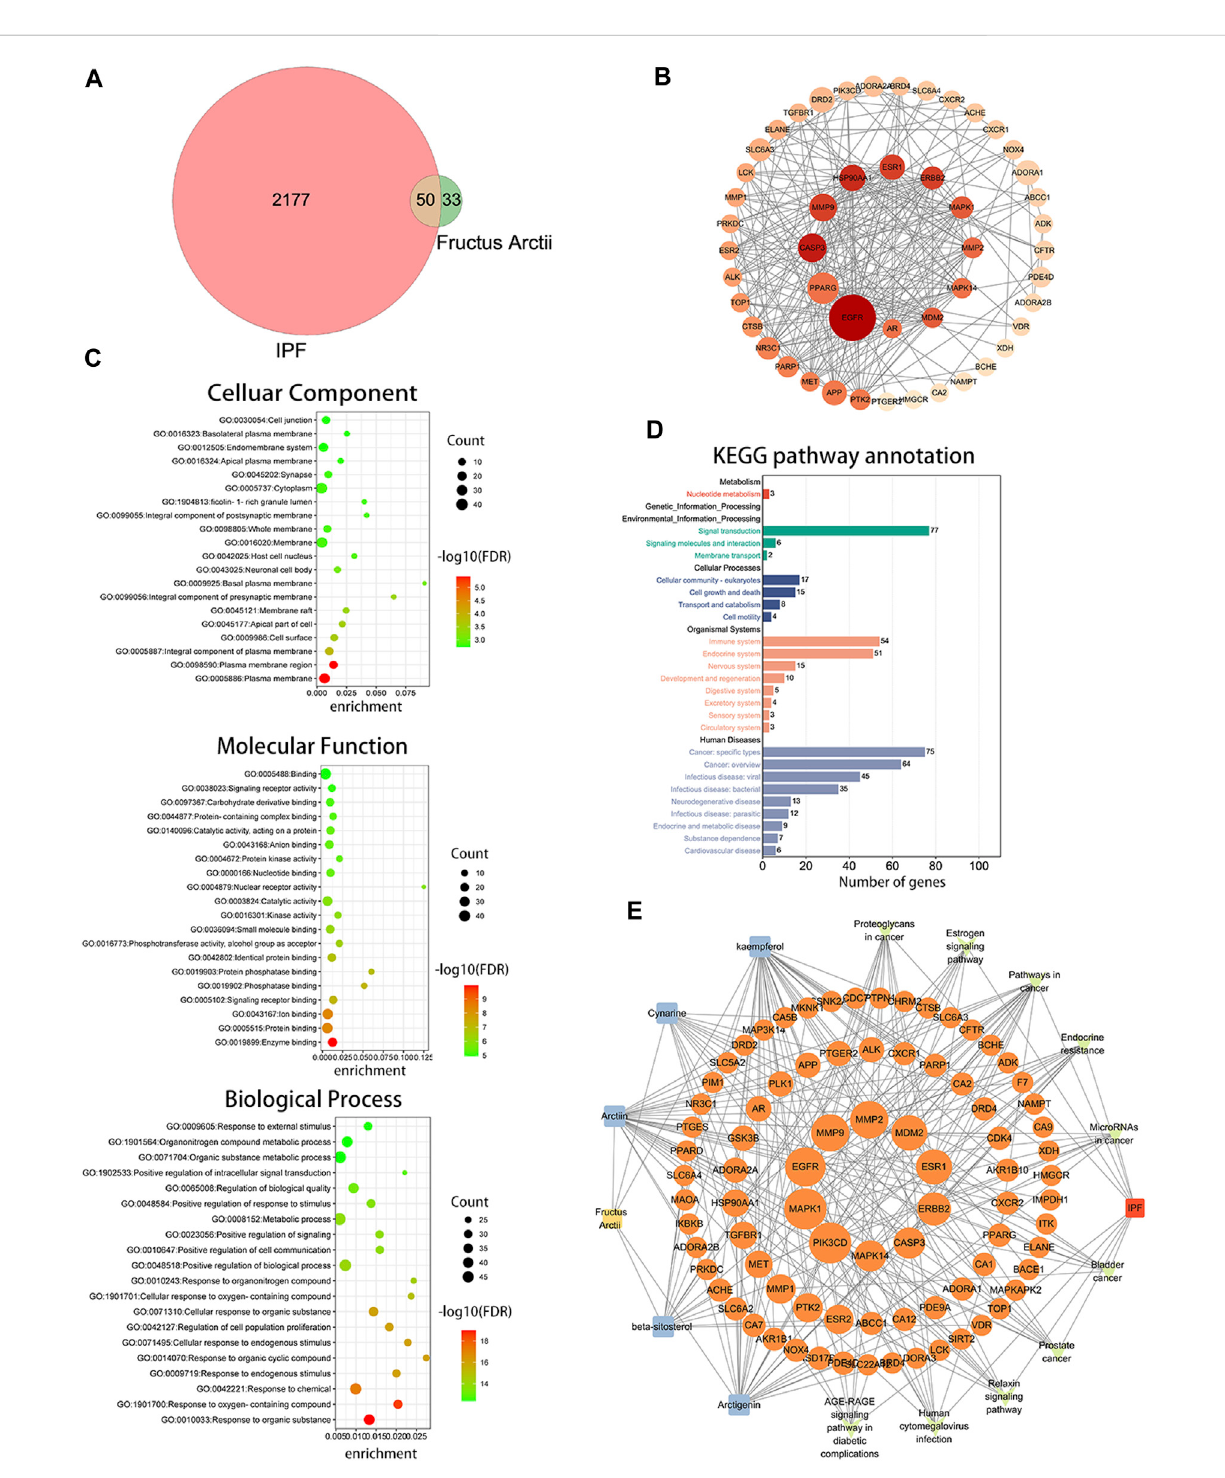
FIGURE 1 Bioinformatics analysis between Fructus arctii and idiopathic pulmonary fi brosis (IPF). (A) Venn diagram summarizing the intersected gene targets between Fructus arctii and the IPF. (B) Proteins and protein interaction (PPI) network of the 50 identi fi ed targets (C,D) The enrichment analysis of Fructus arctii targets against IPF by gene Ontology and Kyoto Encyclopaedia of Genes and Genomes analysis of intersections network (E) Medicine-Ingredient- Target-Disease network model of Fructus arctii and